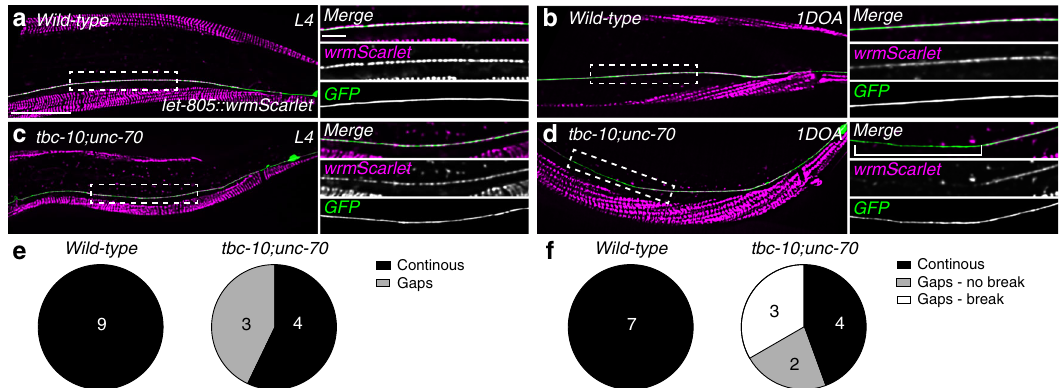
Fig. 5 LET-805/myotactin localization is disrupted in tbc-10;unc-70 mutants. a , b Deconvolved spinning disk confocal maximum projection of typical endogenous LET-805::wrmScarlet localization (magenta) at the L4 ( a ) and 1-day-old adult (1DOA) ( b ) stage in wild-type animals from a lateral perspective, with the PLM neuron labeled with a GFP ( Pmec-4::GFP ). The side panels in a – d show the boxed area indicated in the left panel as a merged image and individual channels. c , d Deconvolved spinning disk confocal maximum projection of typical endogenous LET-805::wrmScarlet localization (magenta) at the L4 ( c ) and 1DOA ( d ) stage in tbc-10;unc-70 animals from a lateral perspective, with the PLM neuron labeled with a cytosolic GFP ( Pmec- 4::GFP ). Open bracket in side panel d indicates the region where LET-805::wrmScarlet localization is absent. Scale bars in a are 25 μ m and 5 μ m in the left and side panels, respectively. e Normalized intensities of LET-805::wrmScarlet along a 50 μ m of the PLM axon at the L4 stage were scored as containing gaps (de fi ned as >5 puncta with intensity values < 0.2 a.u.) or continuous attachment (de fi ned as < 5 puncta with intensity values < 0.2 a.u.). f LET-805:: wrmScarlet localization at the 1DOA stage was scored as continuous (no gaps in localization greater than 10 μ m) or containing gaps (a region of no localization greater than 10 μ m) with and without axonal breakage. N -values are indicated on charts and represent the number of individual animals scored for each Fig. 6G – L). Interestingly, each single mutant had opposing effects on the membrane levels of LET-805::wrmScarlet in each stage. At the L4 stage unc-70 animals had a reduced intensity of LET-805:: wrmScarlet (Supplementary Fig. 5F), while in 1DOAs tbc-10 mutants displayed an increase in the level of LET-805::wrmScarlet at the membrane compared to wild-type animals (Supplementary Fig. 5F).